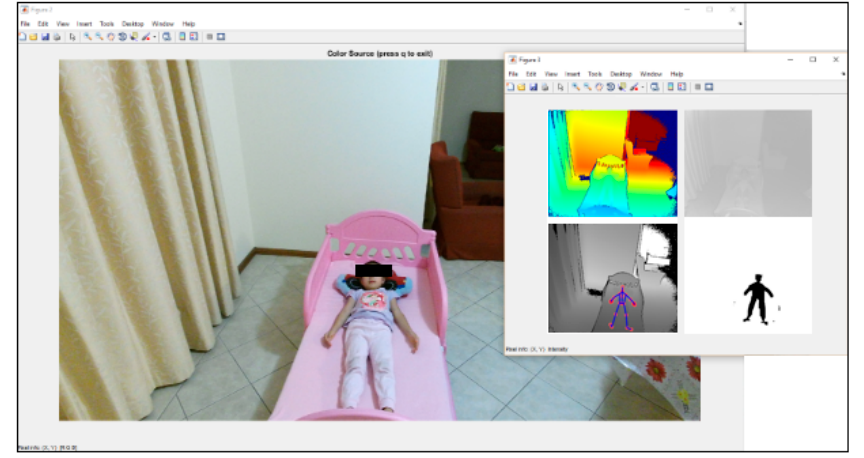
Figure 4. Red, green & blue image, depth map, thermal, skeleton tracking, and body index from the Kinect v2 sensor. the Kinect v2